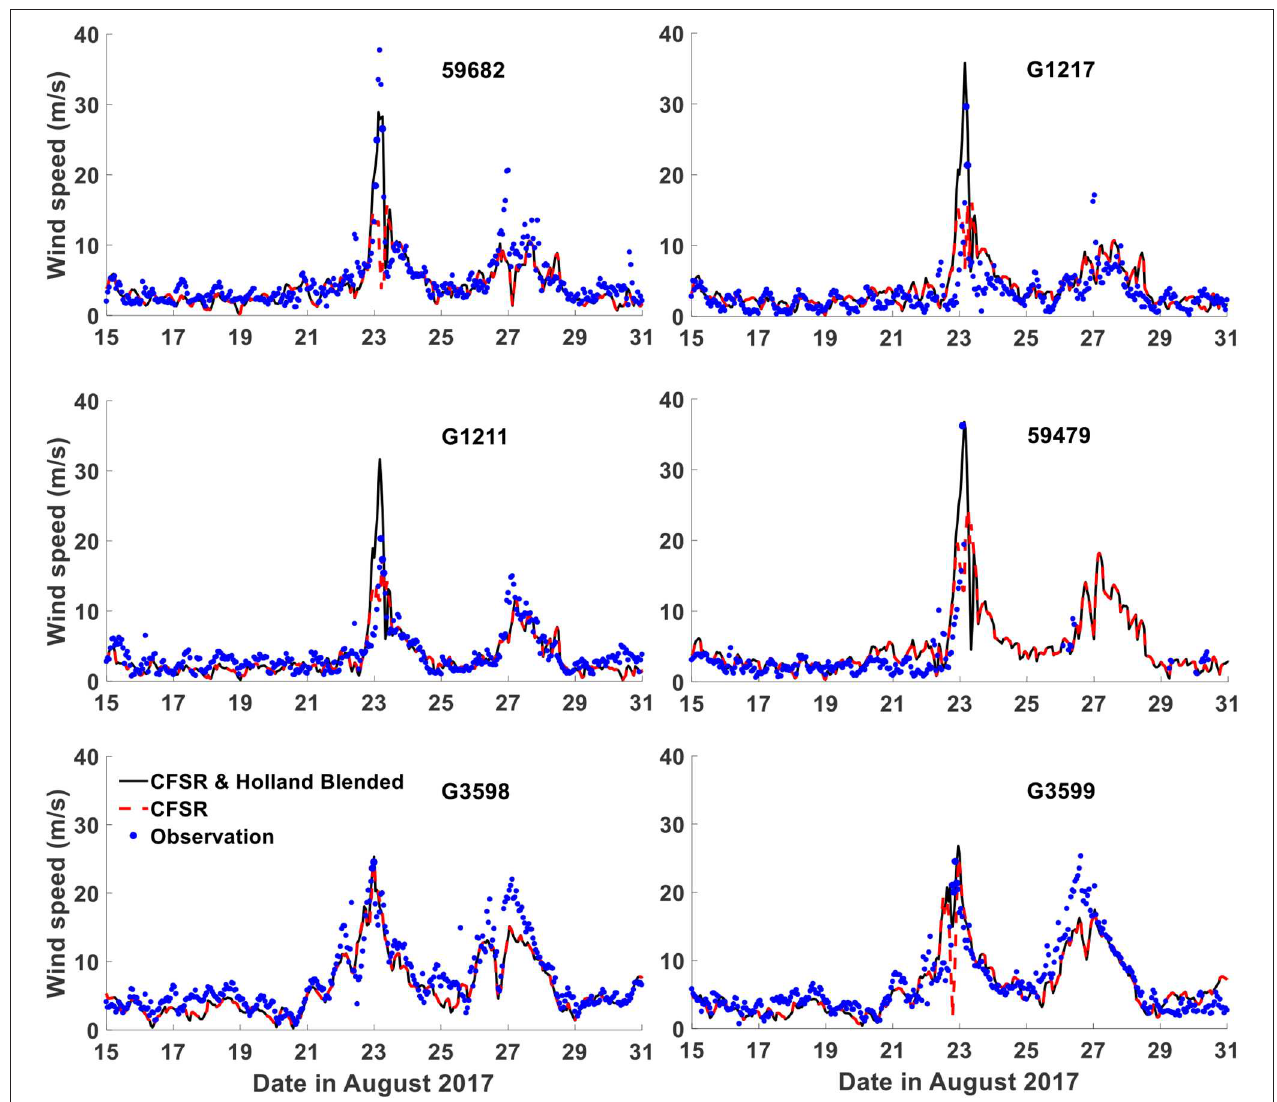
FIGURE 3 | Comparisons of wind speed from CFSR and Holland model blended data (black line), CFSR dataset (red line), and observations (blue